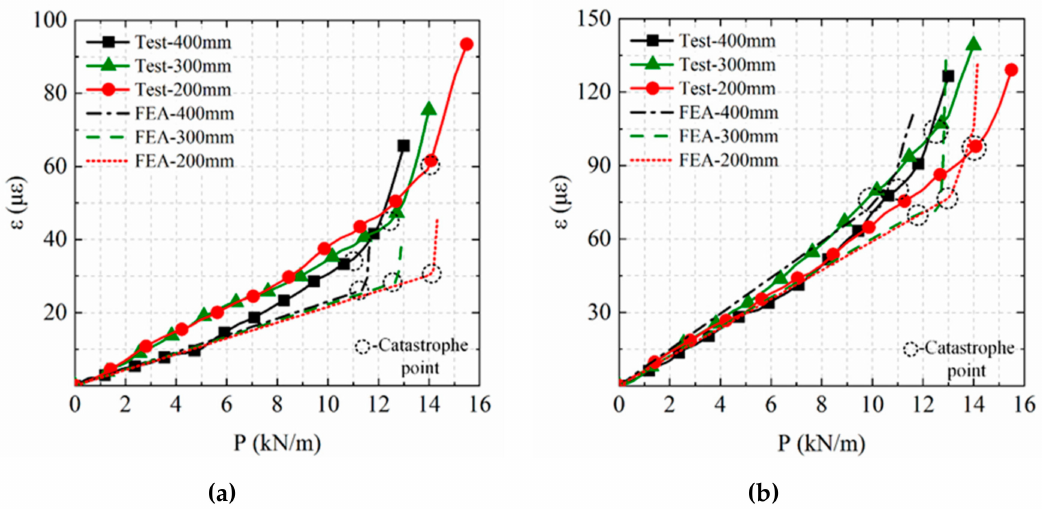
Figure 16. Load–strain curves of the pipes containing cracks with di ff erent lengths: ( a ) outer wall at the springline and ( b ) inner wall at the